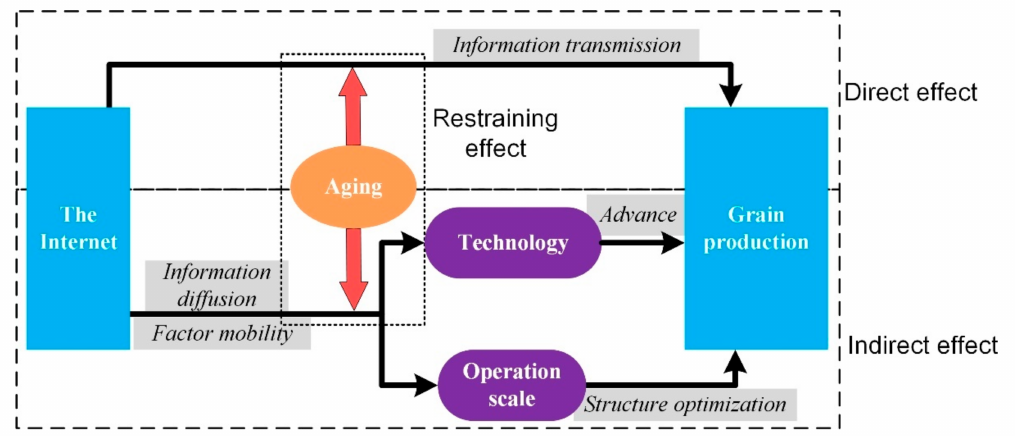
Figure 1. Analytical